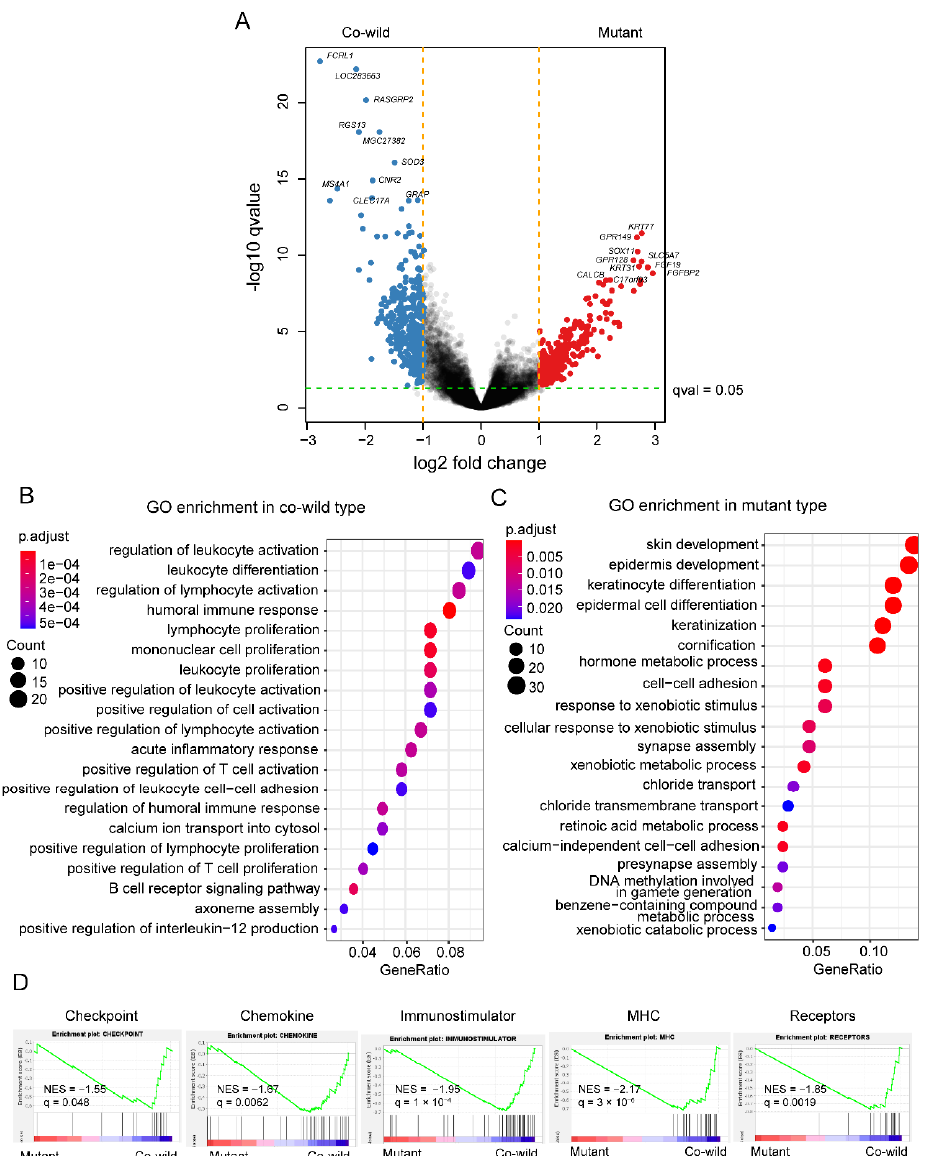
Figure 5. The RNA expression difference between TP53 / LRP1B mutant and co-wild LUSC. ( A ) The results of differentially expressed genes analysis between TP53/LRP1B mutant and co-wild LUSC. The labels represent the top 10 genes that significantly changed in the two types. ( B , C ) The results of GO enrichment in TP53/LRP1B co-wild and mutant co-wild LUSC. ( D ) The results of GSEA analysis base on immune-related gene sets. NES, normalized enrichment score; q, adjusted p value. 3.6. TP53/LRP1B Co-Wild LUSC Was Associated with an Activated Immuno-Phenotype Tumor-infiltrating lymphocytes (TILs) were estimated using TCGA RNA data to characterize the tumor immune microenvironments. We first used the ssGSEA to identify immune cell types. Compared with the mutant type, the co-wild type had a significantly increased proportion of multiple TILs, including activated CD8 T cell, activated dendritic cell (DC), central memory CD4 T cell, effector memory CD8 T cell, macrophage, MDSC,